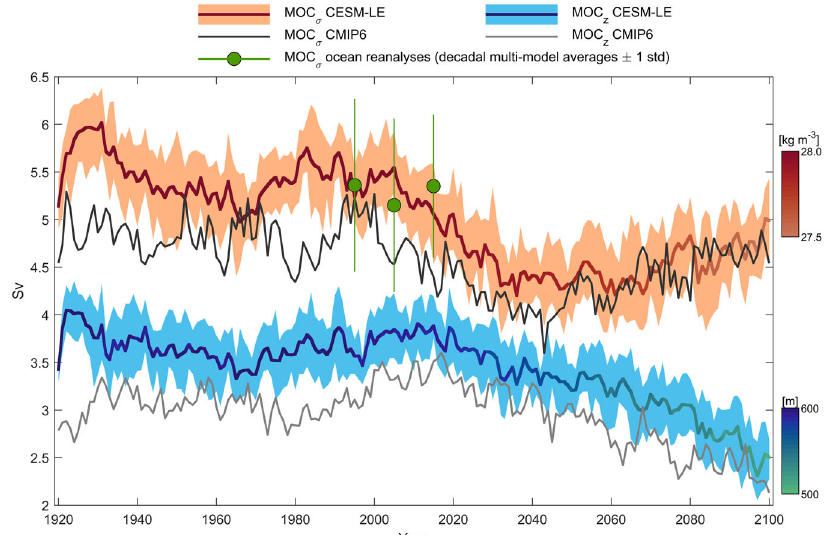
Fig.2|NordicSeasoverturning. Timeseriesofmaximumoverturningstrengthat 70°N in density (MOC σ ) and depth-space (MOC z ) in CESM-LE and CMIP6 models. For CESM-LE, solid lines show the ensemble mean and the shading indicates the interquartile spread. The color of the solid lines indicates the density and depth of the maximum overturning circulation in density-space and depth-space,